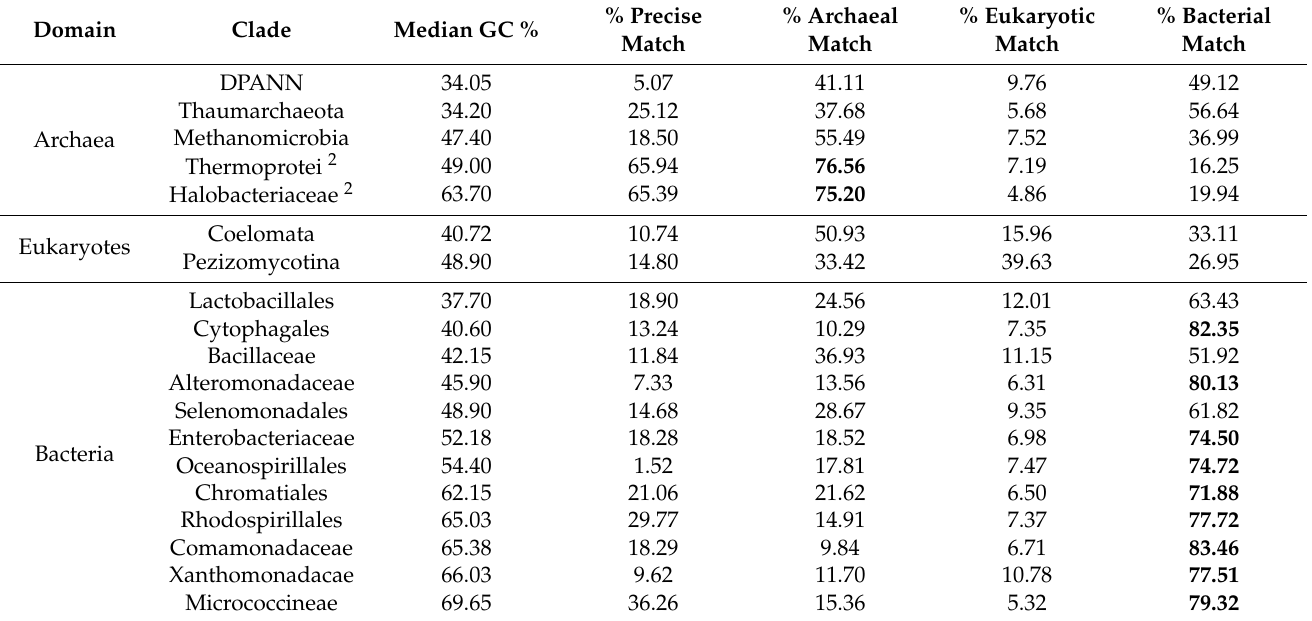
Table 1. Recall for the novel models when they were used as classifiers 1